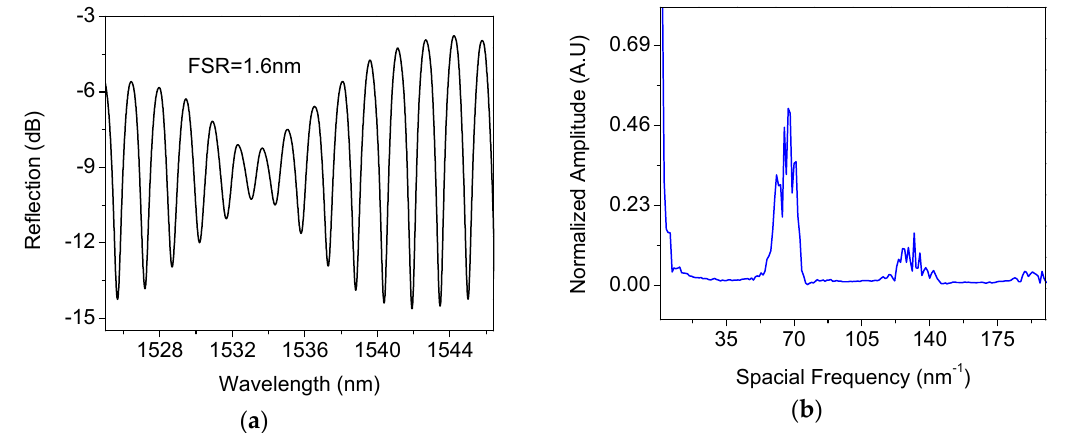
Figure 1. Physical characteristics of the MFI structure: ( a ) structure diagram; ( b ) Scanning Electron Microscope Image (SEM) of the structure.